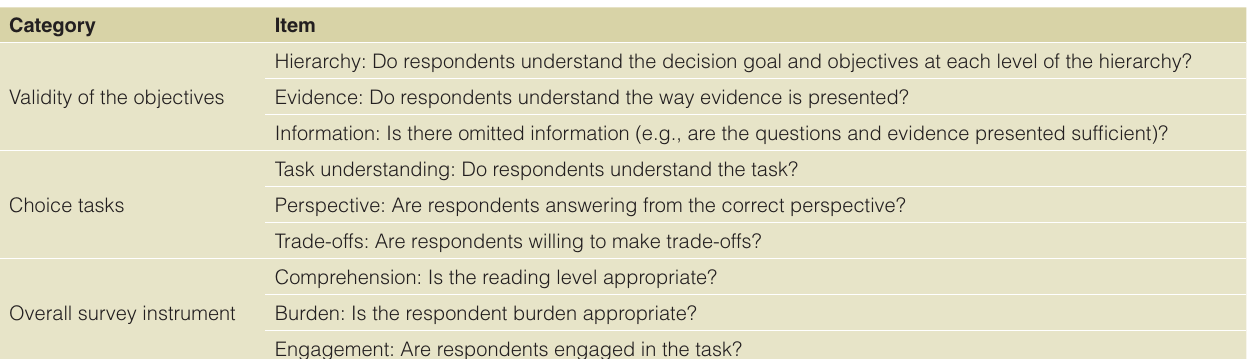
Table 1. Checklist used to guide cognitive interviewing. Category Item